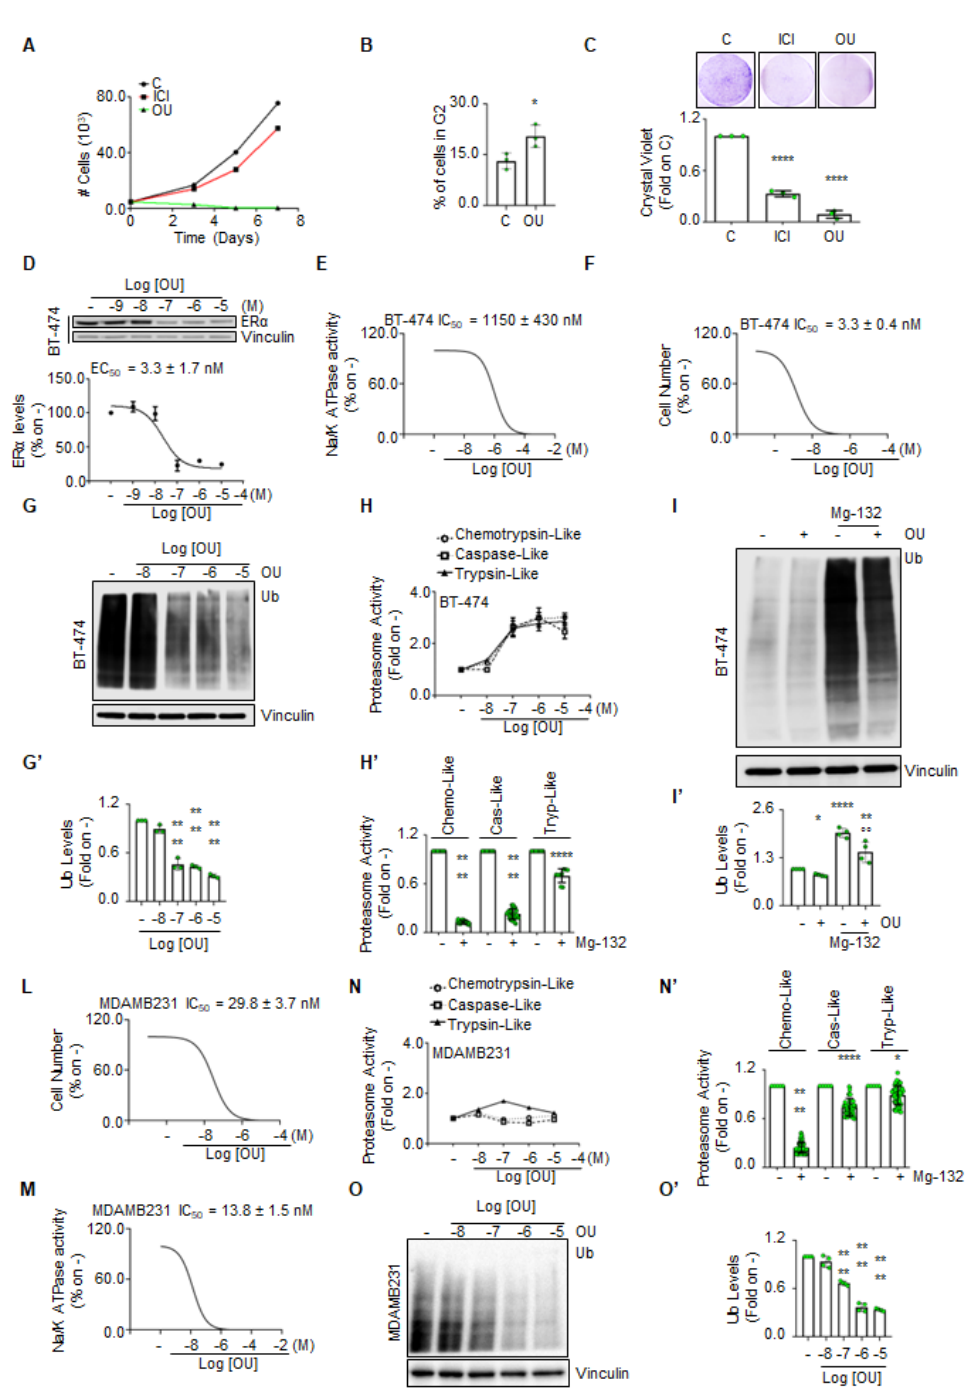
Figure 2. The impact of ouabain in the regulation of cell proliferation and ER α levels in BT-474 cells. ( A ) Growth curve analysis in BT-474 cells treated with ouabain (OU-100 nM), and fulvestrant (ICI182,780, ICI-100 nM) for the indicated time points. ( B ) Percentage of the BT-474 cells in the G2 phase of the cell cycle detected after 24 h of ouabain (OU—100 nM) administration. * indicates significant differences, calculated with Student t-test, with respect to C, p -value < 0.05. Data are the mean ± the standard deviation of three independent experiments. ( C ) Colony formation assays in BT-474 cells treated for 3 weeks in the presence or the absence of either ouabain (OU-100 nM) or fulvestrant (ICI182,780, ICI-100 nM). **** indicates significant differences, calculated with Anova, with respect to C, p -value < 0.0001. Data are the mean ± the standard deviation of three independent experiments. ( D ) Western blot and relative densitometric analyses of ERα levels in BT -474 cells treated for 24 h with the indicated doses of ouabain (OU). ( E ) Na/K ATPase activity and ( F ) number